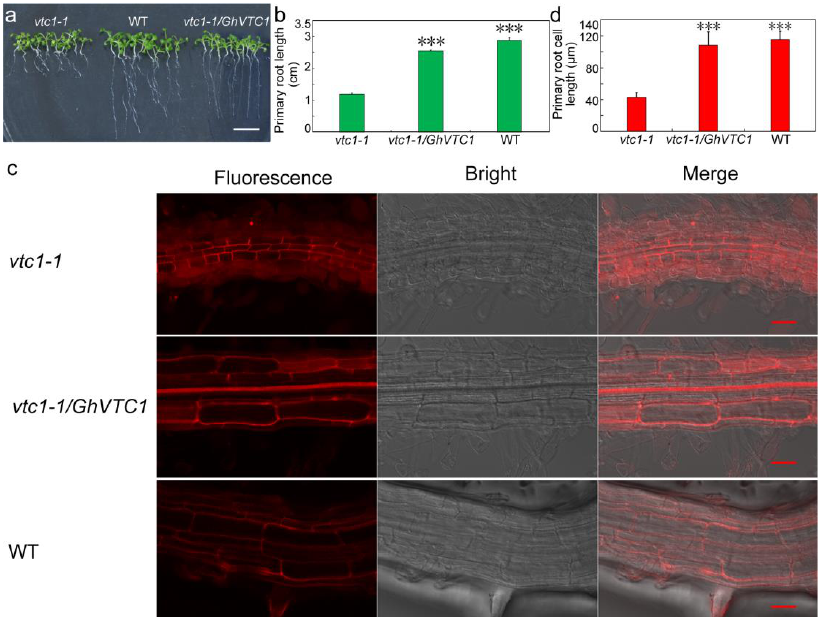
Figure 5. GhVTC1 promotes the root cell elongation of Arabidopsis vtc1-1 mutants. The phenotypes of primary roots of vtc1-1 , vtc1-1/GhVTC1 , and WT Arabidopsis materials were observed ( a ), and the primary root lengths were measured ( n = 30) ( b ). ( c ) Fluorescence images of Arabidopsis primary root cells by confocal laser-scanning microscopy. ( d ) The root cell lengths were measured ( n = 100). Bars = 1 CM (in a ) and 50 μm (in d ). ***, p < 0.001 compared to vtc1-1 .